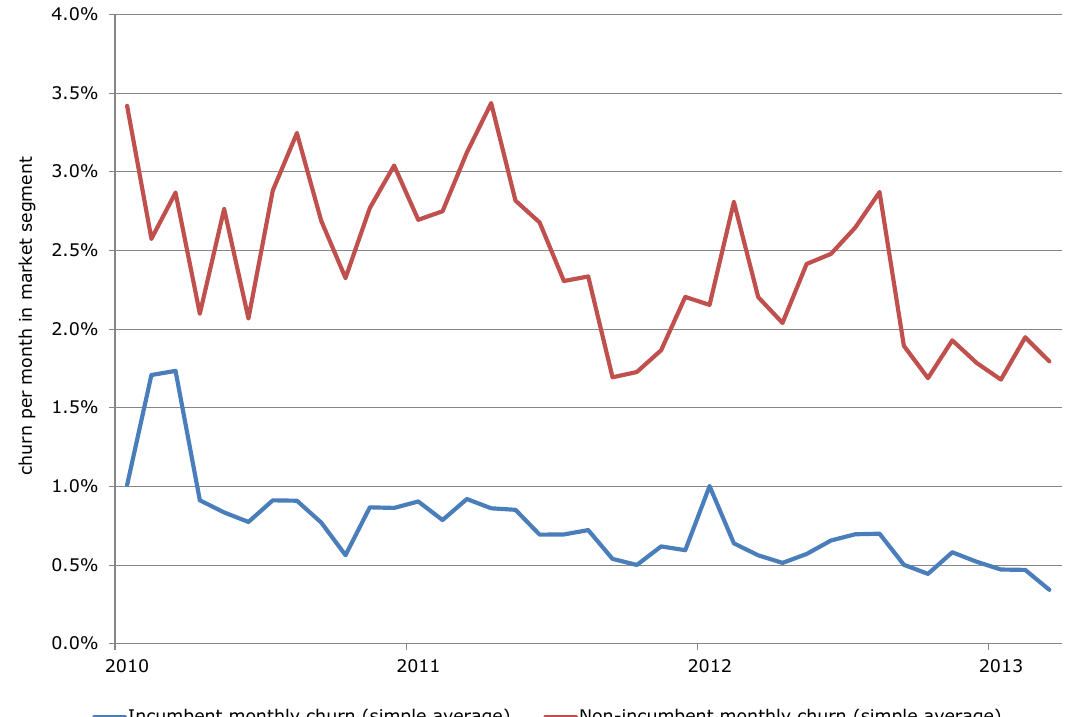
Figure 23: Average legacy electricity supplier single-fuel electricity customer switching in their incumbent regions versus legacy supplier single-fuel electricity switching in other